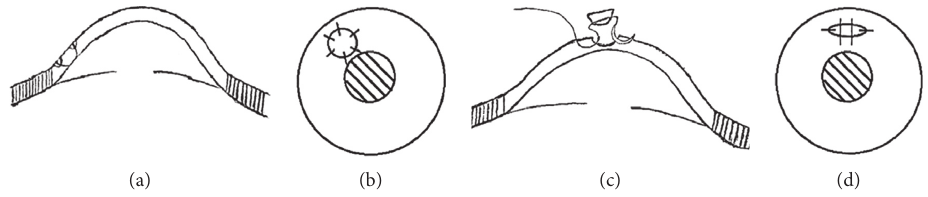
Figure 1: Corneal patching with a conical/irregular wedge-shaped graft. (a-b) Penetrating corneal patching with a conical graft. The graft is sutured onto the host bed with interrupted sutures. (c-d) Lamellar corneal patching using an irregular wedge-shaped graft. The graft width is ＜ 1.5mm, and the suture starts from the host cornea to the graft and finally through the host cornea on the opposite side. This continuous suture method is also applicable for penetrating corneal